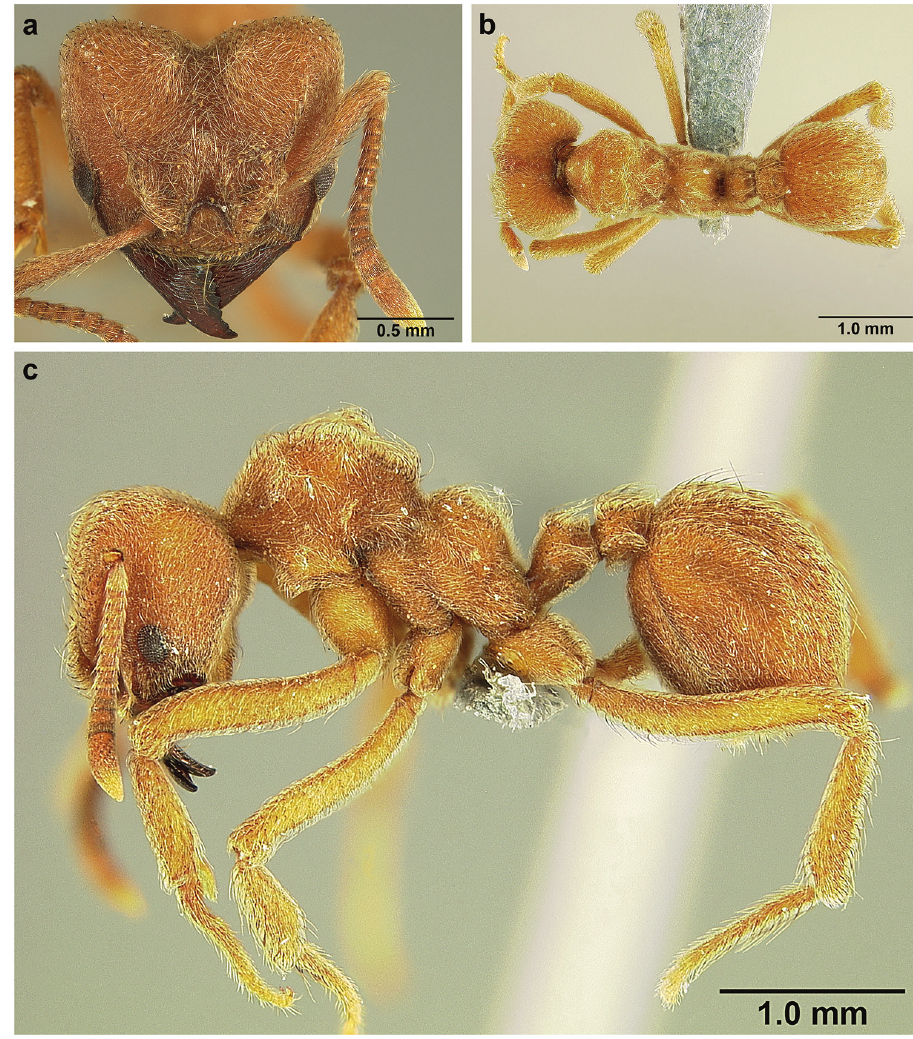
Figure 36. S. mayri worker (USNMENT01125171). a Head b dorsal view; and c lateral Metasoma. Petiole and postpetiole each with two low, short, serrate, longitudinal carinae dorsally, on petiole sometimes reduced to low denticles, best seen in dorsolat- eral view. Postpetiole usually with another pair of low carinae laterally. First gastral tergite with lateral carinae well developed, dorsal carinae absent or faint. S. mayri queen description. Measurements in mm, range: HWe 1.44–1.64 HW 1.48–